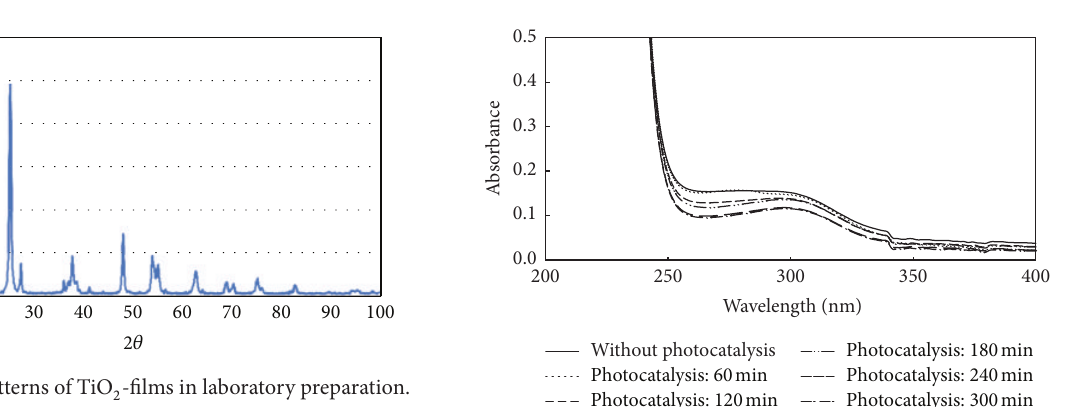
Figure 4: XRD patterns of TiO 2 -films in laboratory preparation.